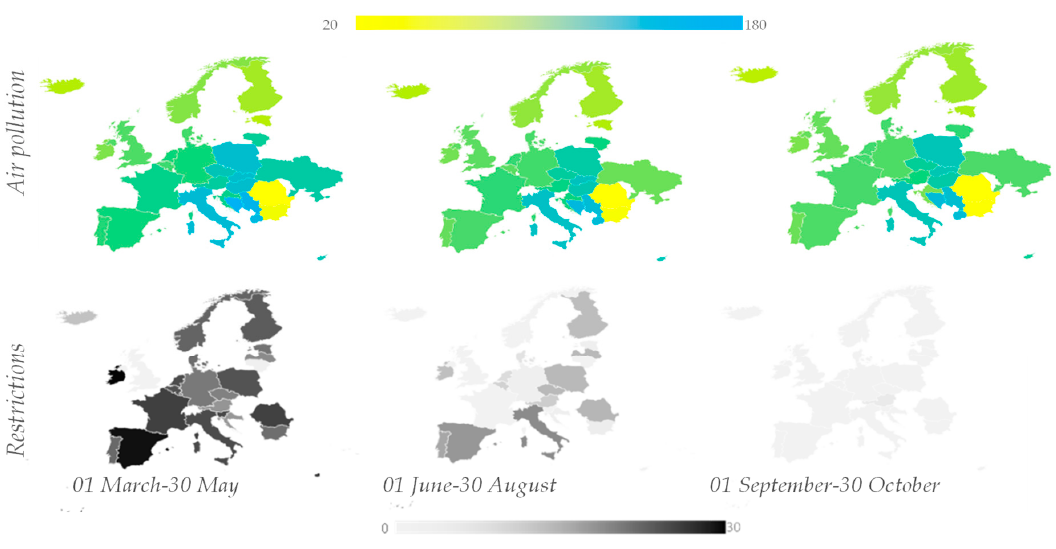
Figure 4. Urban air pollution (colored scale) and restrictions (black–grey scale) in Europe in three periods: 1 March–30 May, 1 June–30 August and 1 September–30 October. The values were composed as follows: